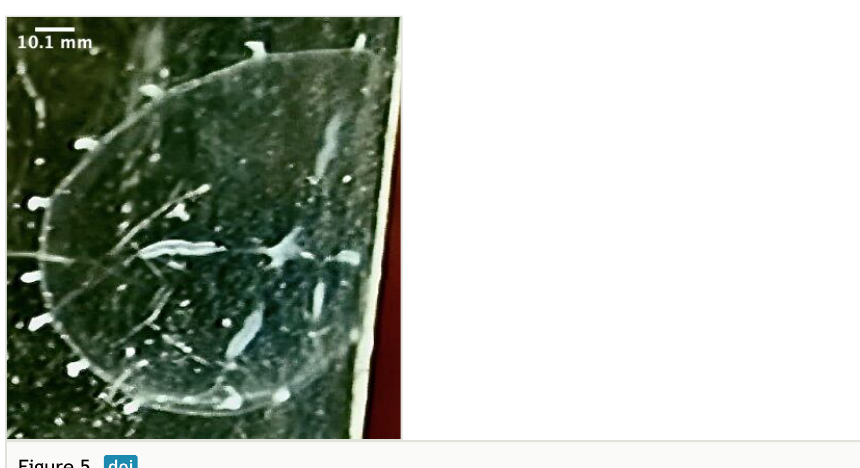
Mitrocomella spotted on Selini Beach, Buleleng Regency, Bali Island. Lateral view of the medusae.